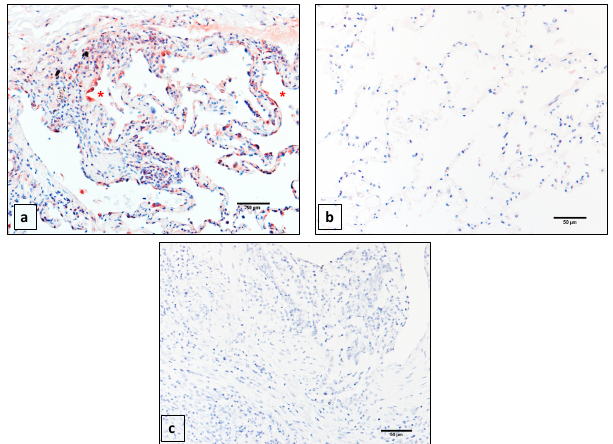
Figure 1. Immunohistochemistry of matrix metalloprotease 14 (MMP14) in idiopathic pulmonary fibrosis (IPF) and control tissues. ( a ) IPF lung showing immunoreactive protein primarily located in epithelial cells (*). ( b ) MMP14 in lung tissue from a normal donor. ( c ) Immunostaining control without primary antibody in lung tissue from IPF. Scale bar 50 µ